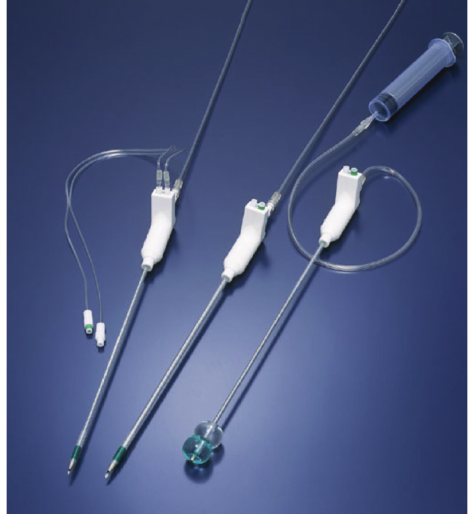
:54.4113000.000 Figure 2: Magnetic resonance imaging showing a large simple cystic retroperitoneal mass.